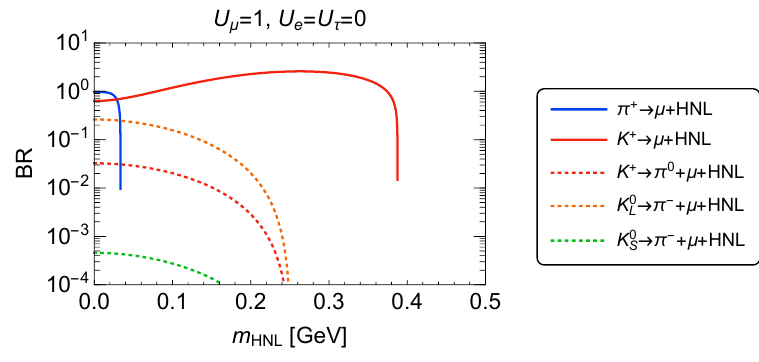
Figure 16 . The same plot as figure 13 but for U µ = 1 , U e = U τ = 0 .